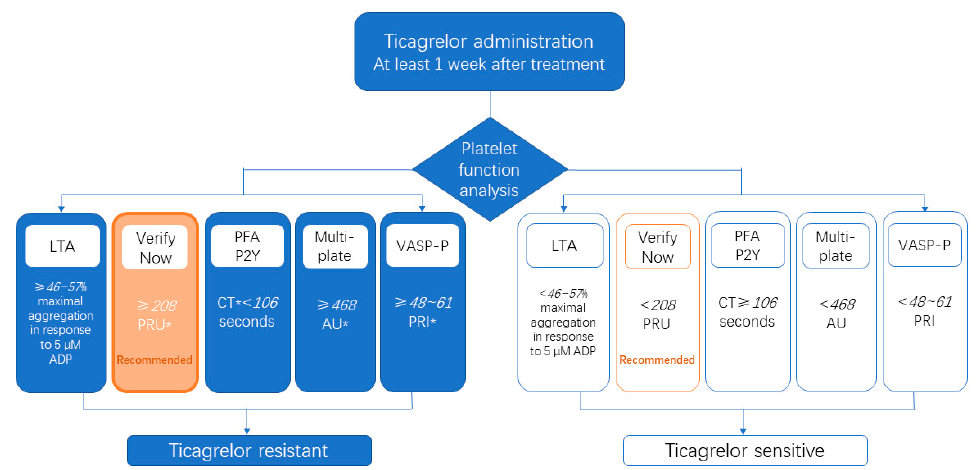
Figure 1. Flow chart for the diagnosis of ticagrelor resistance.* PRI, platelet reactivity index; PRU, platelet reactivity units; CT, closure time; and AU, aggregation units.